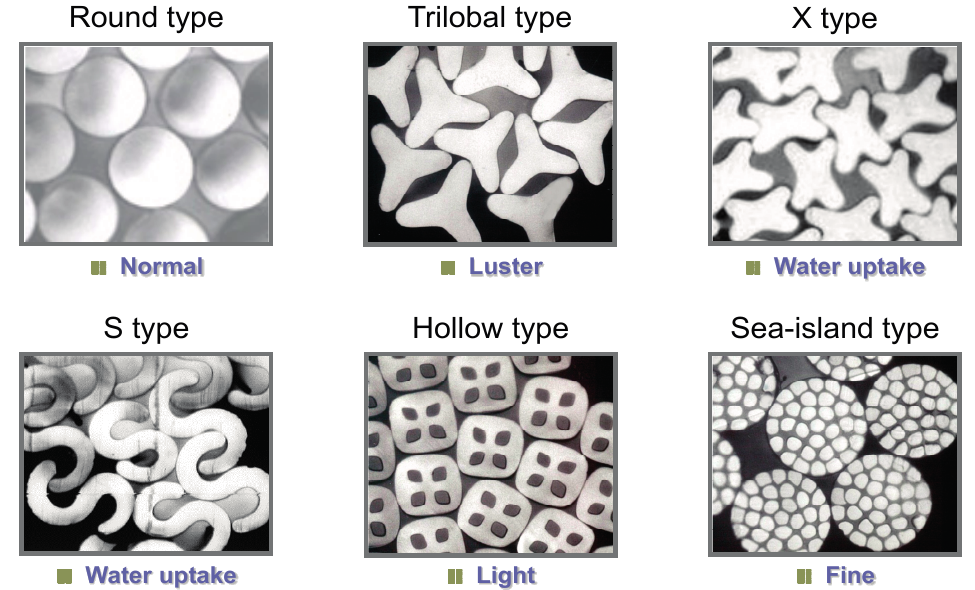
Figure 6. Various fiber cross-sections obtained for the first melt-spun cellulose fiber “Foresse ® .”